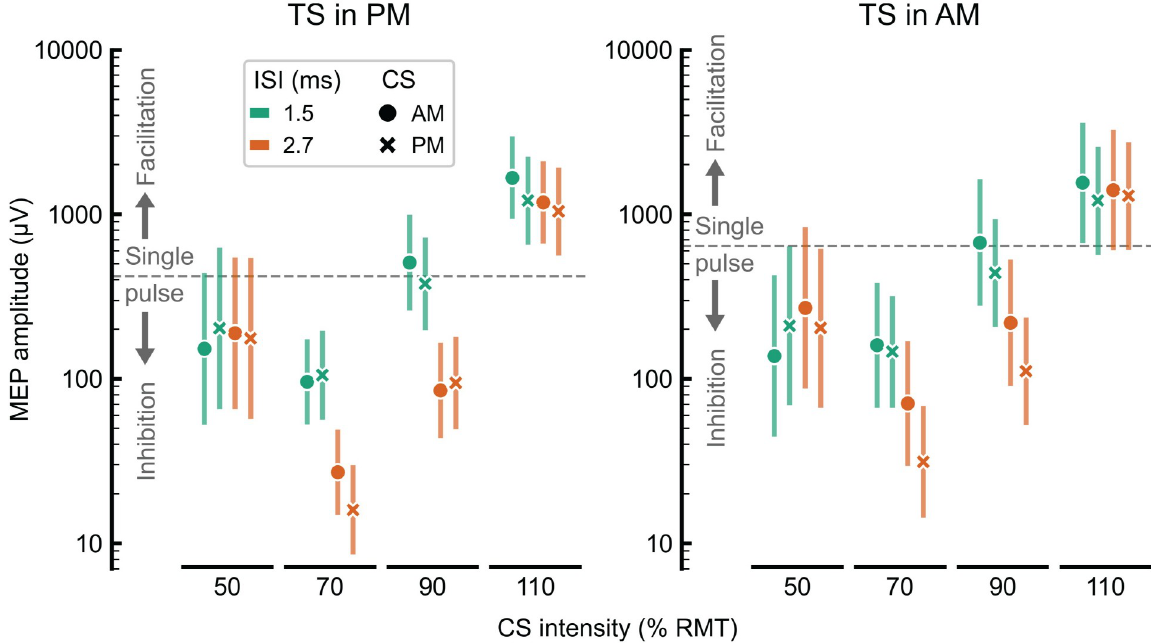
Fig 2. MEP amplitude from the linear mixed-effects model as a function of the CS and TS orientation and the CS intensity at 1.5- and 2.7-ms ISIs. The median single-pulse MEP amplitude is marked by the dashed horizontal line. The left and right panels represent the data for the TS in the AM and PM orientations, respectively. MEPs induced by paired-pulse stimulation are grouped by the CS intensities (50, 70, 90, and 110% RMT), and subdivided into two ISIs (1.5 ms–green, and 2.7 –orange), and CS orientations (AM orientation, dots; PM orientation, crosses). The error bars represent the 95% confidence interval of the estimated marginal